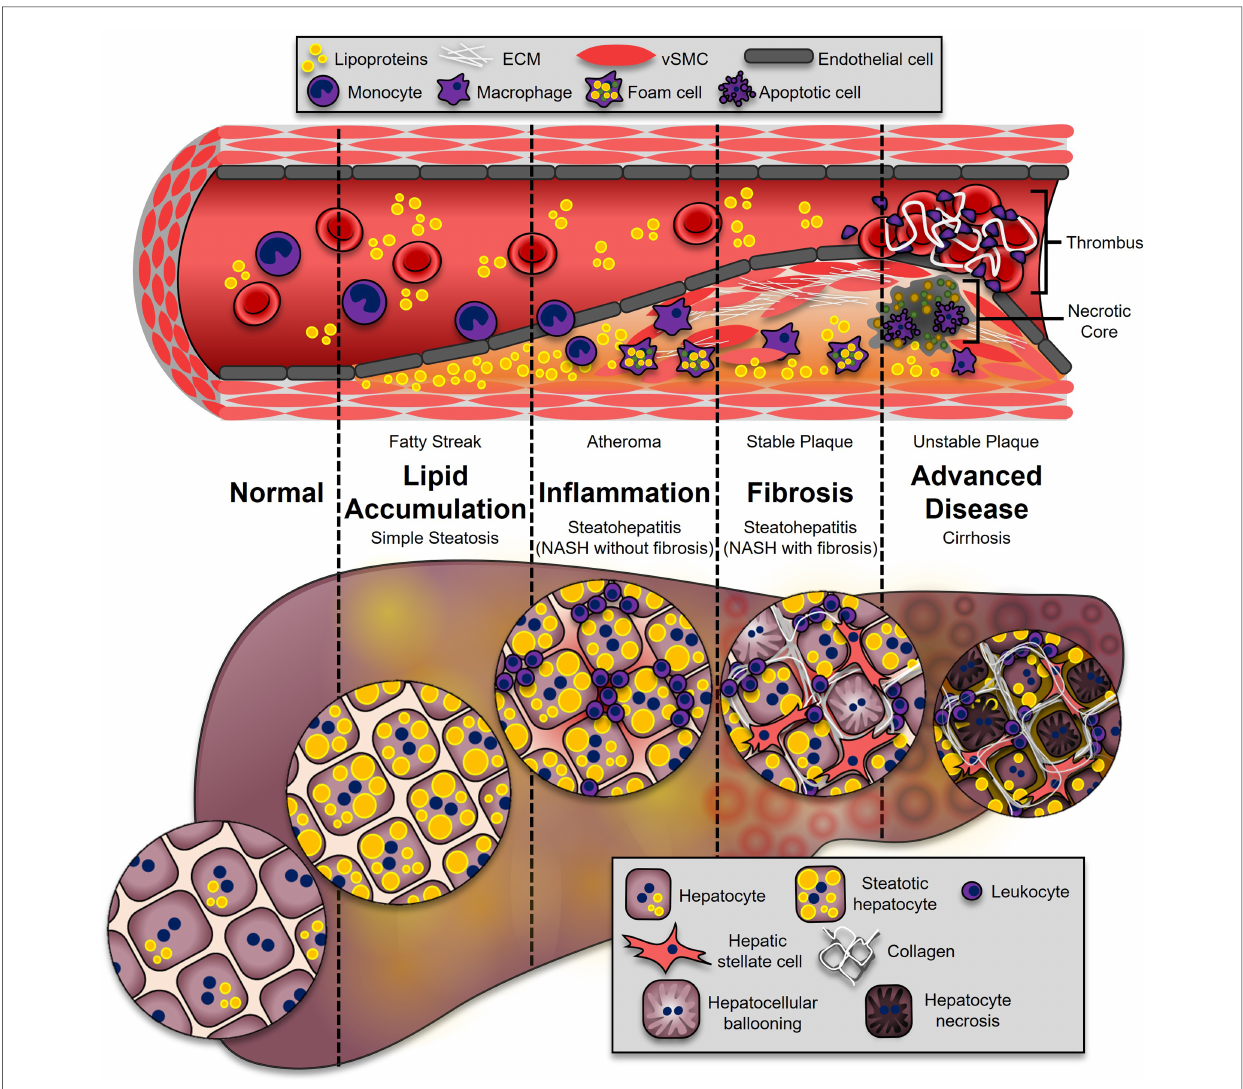
FIGURE 1 Progression of ASCVD and NASH. The onset of both ASCVD and NASH begins with dysregulated lipid metabolism, leading to their accumulation in the neointimal region of the artery (fatty streak), or the hepatocytes (simple hepatic steatosis). This process enhances in fl ammatory pathways in both diseases. During atherosclerosis, leukocytes adhere and transmigrate into the developing plaque, where they secrete additional cytokines and chemokines (atheroma). In the liver, leukocytes from the circulation accumulate, leading to NASH (NASH without fi brosis). These immune cells secrete soluble factors to activate collagen-producing cells: synthetic vascular smooth muscle cells (vSMCs) in atherosclerosis (stable plaque), and hepatic stellate cells in the liver (NASH with fi brosis). The most advanced stages of disease are associated with higher mortality. In atherosclerosis, advanced plaques with a large necrotic core and thin fi brous caps are prone to rupture (unstable plaque), which is highly thrombogenic. In the liver, excessive fi brosis and cell death leads to irreversible damage and loss of liver function